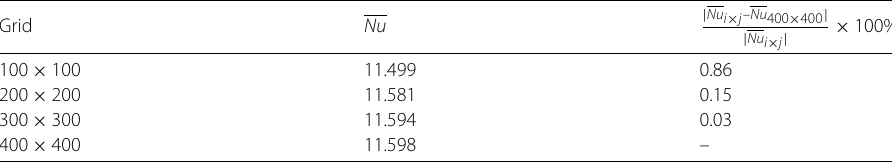
Table 4 Variation of Nu with the grid, Ra = 1000, Bi = 100, uniform grid Grid